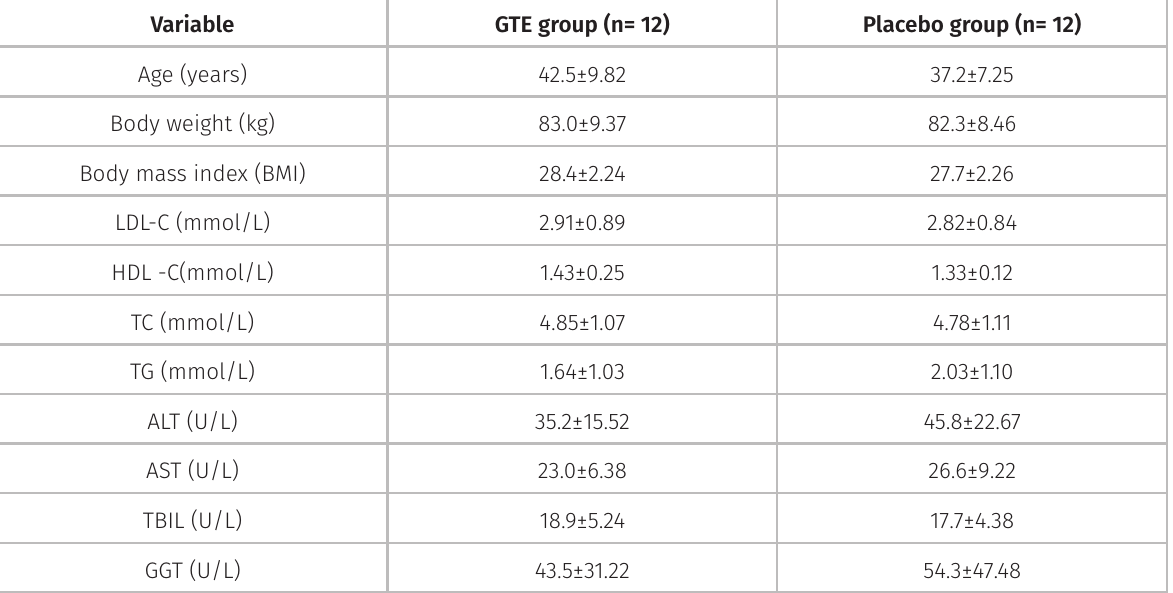
Table I. Subject characteristics at